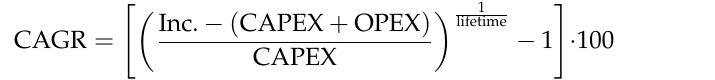
Figure 3. Schematic of the behaviour of each agent in every time-step of the simulation.